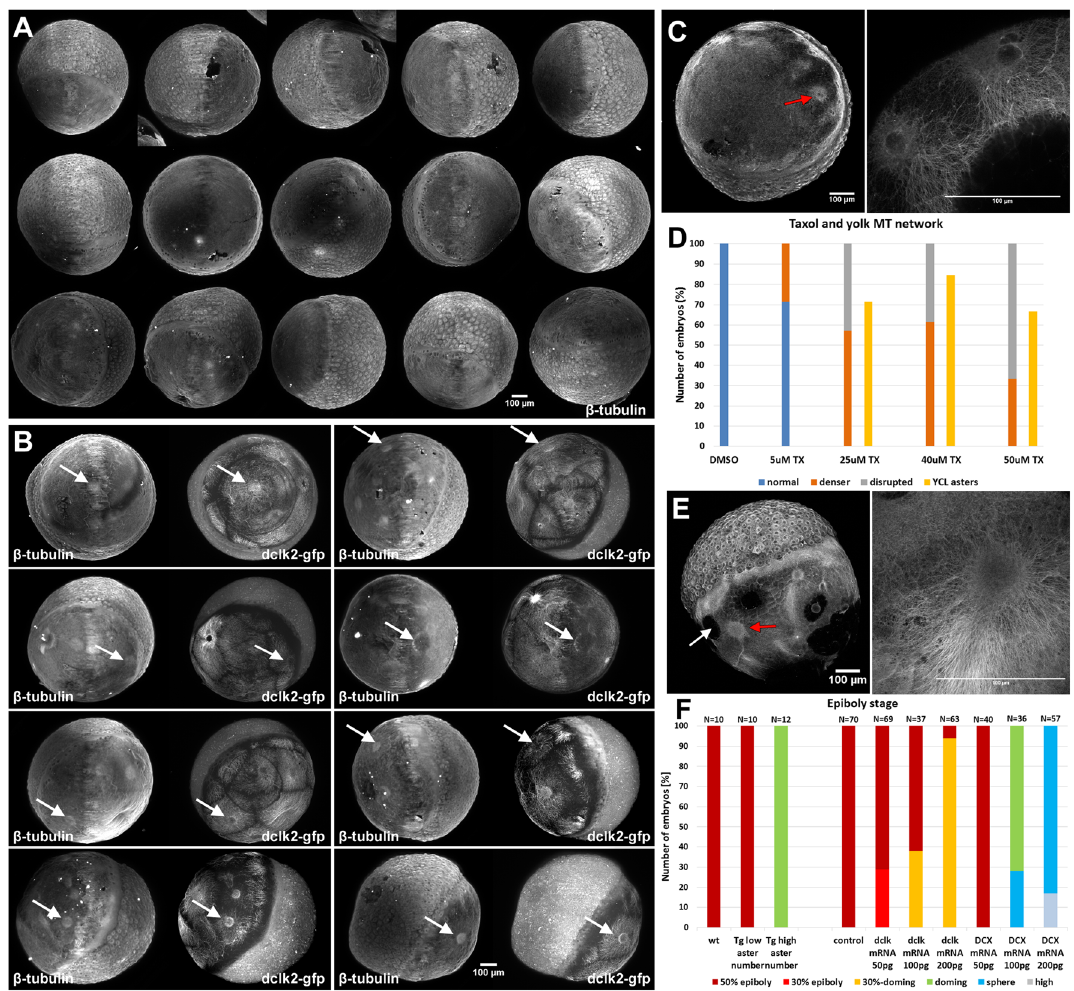
Figure 2. Natural and induced formation of YCL asters. ( A , B ) LSFM high-throughput screening of stained, previously fixed, embryos. ( A ) N = 15 wt embryos and ( B ) N = 8 dclk2-GFP embryos, immunostained against β-tubulin. On dclk2-GFP embryos, immunostaining reveals a high concentration of β-tubulin colocalizing with the dclk2-GFP signal in the YCL asters (white arrows in B ). YCL asters are not visible in any wt embryo ( A ). ( C ) YCL asters form in the YCL upon dclk2-GFP overexpression in wt embryos. Ectopic asters appear in random positions (red arrow). Left: β-tubulin-stained embryo, low magnification vegetal view. Right: zoom in a couple of neighbouring asters. ( D ) Effect of Taxol on the organization of yolk MTs. Wt embryos were incubated with increasing drug concentrations from sphere stage. The yolk MT organization was evaluated in embryos fixed at 50% epiboly and immunostained for β-tubulin. The percentage of embryos with a denser (thick MTs) and a disrupted yolk MT network (MT bundles and MT free patches) increased progressively with higher drug concentration, compared to the normal organization of the yolk MT network in DMSO- incubated embryos (5 µM, N = 7; 25 µM, N = 7; 40 µM, N = 13; 50 µM, N = 12; DMSO, N = 15). Moreover, YCL asters appear from 25 µM Taxol dose. (TX: Taxol). ( E ) Representative wt embryo incubated with 40 µM Taxol and immunostained for β-tubulin. YCL asters appear in random positions (red arrow) and coexist with MT free regions (white arrow). Left: β-tubulin-stained embryo, low magnification lateral view. Right: zoom in one YCL aster. ( F ) Epiboly stage comparison between embryos of different conditions. Transgenic embryos with a high number of asters are delayed compared to their transgenic siblings having a small number of asters and compared to wt sibling embryos (first three columns in the graph). When control embryos (DMSO injected) are compared to dclk2-gfp and DCX-gfp mRNA injected embryos, epiboly delay correlates with the level of proteins overexpression (seven last columns in the and performed a high-throughput screening with our custom-made LSFM (Fig. 2A,B). This immunostaining was expected to highlight MTs and MTOCs in the whole embryo. YCL asters were clearly highlighted with the β-tubulin staining in the dclk2-GFP transgenic embryos, but we were unable to find YCL asters in wt embryos. Thus, the yolk MT network organization mediated by multiple YCL asters appears a particular mechanism used by the dclk2-GFP transgenic line.